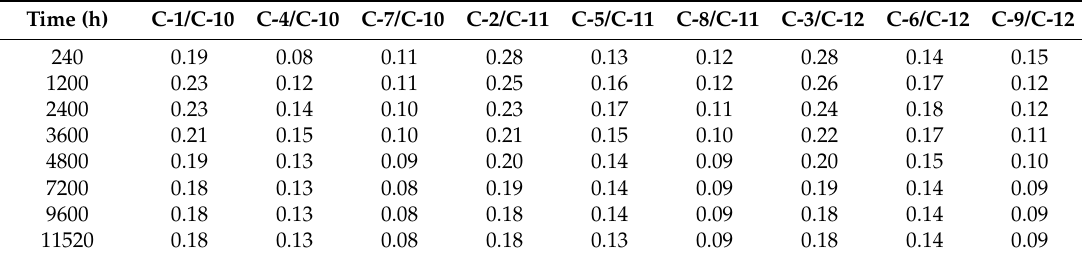
Table 7. The effects of lateral restraint and different steel ratios on the creep of concrete.